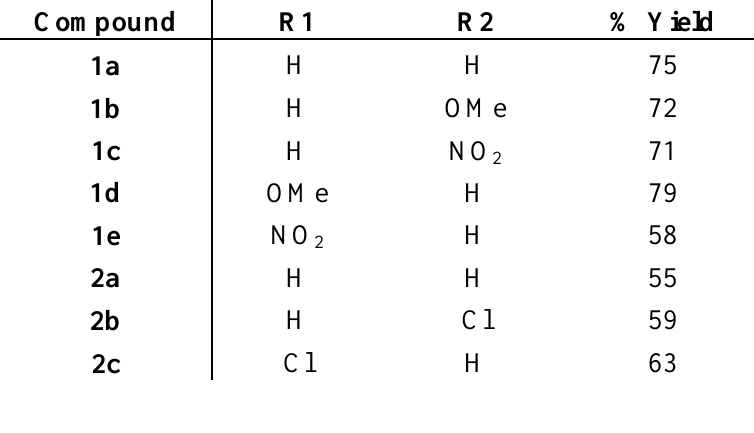
Table . Selected examples of N-(2-phenoxyethyl)anilines 1 and 2